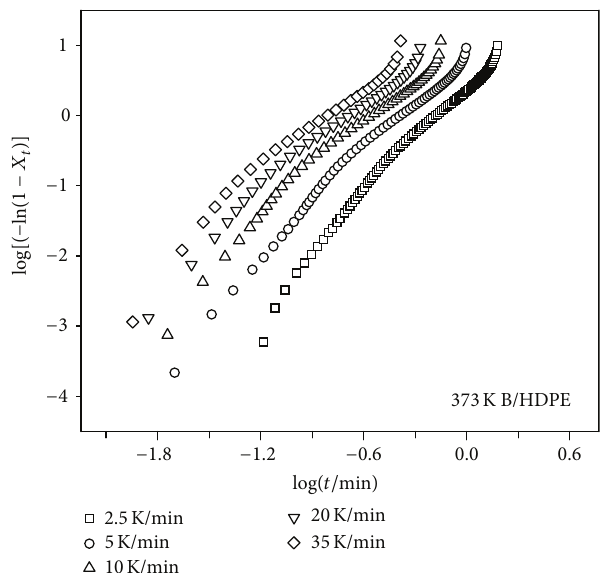
Figure 4: Plots of log [− ln (1 − 𝑋 𝑡 )] versus log (𝑡) for HDPE/heat- treated BF composites (BF with a heat-treatment temperature of 373